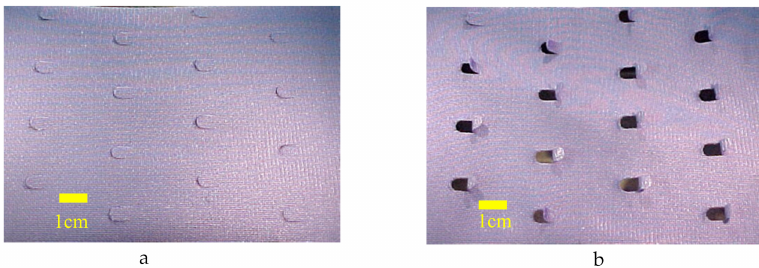
Figure 5. Photograph of original pinecone e ff ect textile in dry ( a ) and damp ( b ) conditions. Sample size is 10 × 5 cm. Pores open when the hygroscopic polyether layer swells on exposure to moisture vapour.